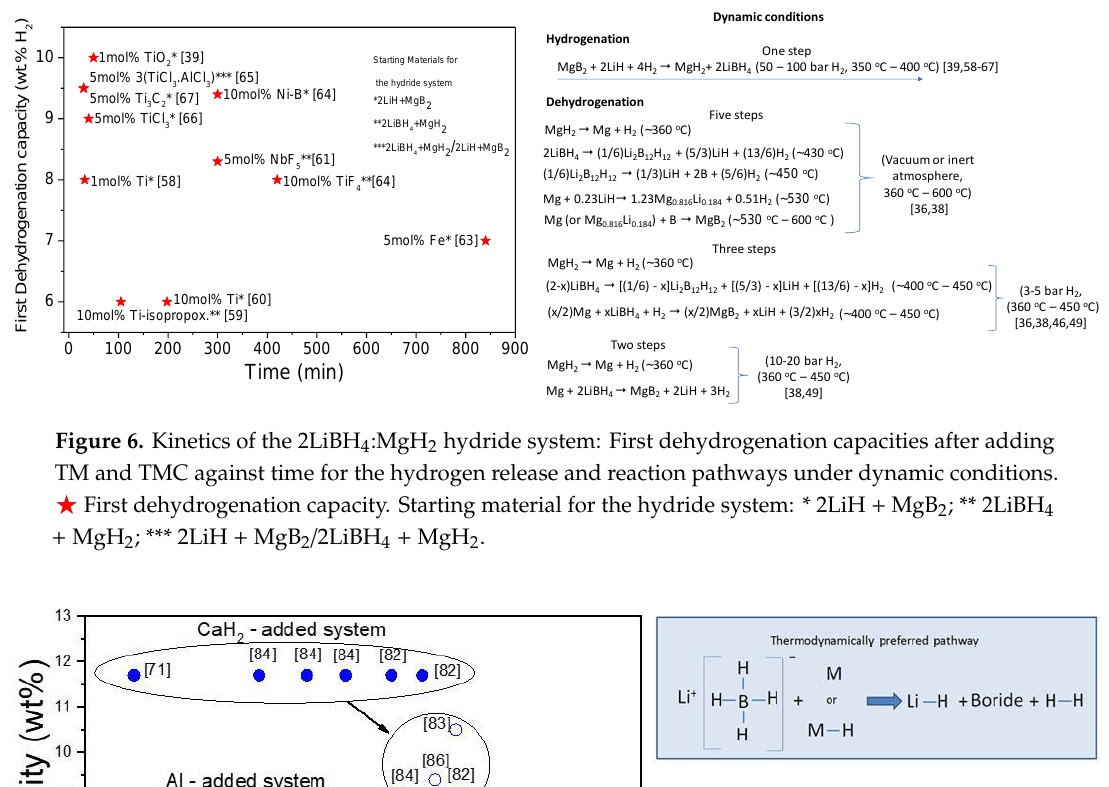
Figure 6. Kinetics of the 2LiBH 4 :MgH 2 hydride system: First dehydrogenation capacities after adding TM and TMC against time for the hydrogen release and reaction pathways under dynamic conditions.